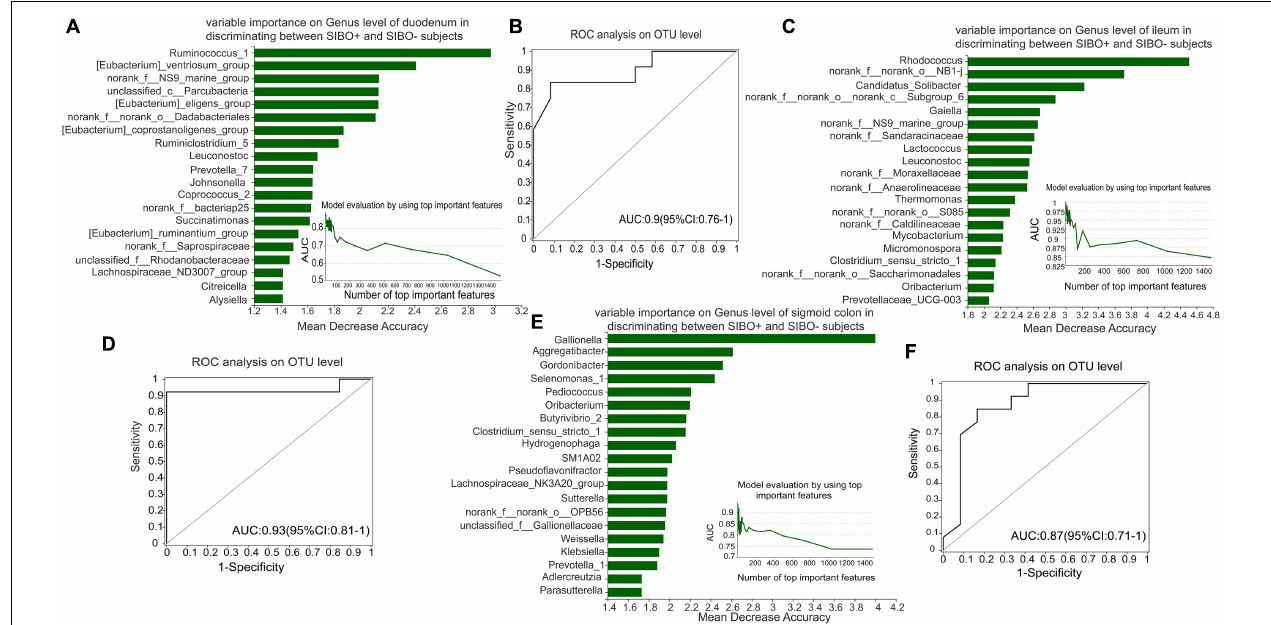
FIGURE 6 | Identification of microbial signatures of SIBO + subjects. Random forest analysis was used to identify taxa in the mucosal samples of the duodenum, ileum, and sigmoid colon to distinguish the SIBO + and SIBO − subjects. The genera were ranked in descending order according to their importance to the accuracy of the model. The insert shows the AUC verification results. X represents the number of species in the importance ranking and Y represents the AUC value. According to the solid point with the largest Y value, the corresponding X value was considered the ultimate number of top species to build a prediction model. The prediction performance was assessed by ROC analysis. (A,B) The random forest analysis showed that use of the top 4 important features (Ruminococcus_1, [Eubacterium]_ventriosum_group, norank_f__NS9_marine_group, and unclassified_c__Parcubacteria) of the duodenal mucosal samples for prediction of SIBO was the most optimal model, and ROC Analysis assessed its prediction performance with an AUC value of 0.9 (95% CI: 0.76–1). (C,D) In the ileum, random forest analysis found that use of the top 3 important features (Rhodococcus, norank_f__norank_o__NB1-j, and Candidatus_Solibacter) to construct the prediction model yielded an AUC value of 0.93 (95% CI: 0.81–1) based on ROC analysis. (E,F) In the sigmoid colon, the random forest analysis found that use of the top 6 important features (Gallionella, Aggregatibacter, Gordonibacter, Selenomonas_1, Pediococcus, and Oribacterium) to build the prediction model yielded an AUC value of 0.87 (95% CI: 0.71–1) based on ROC